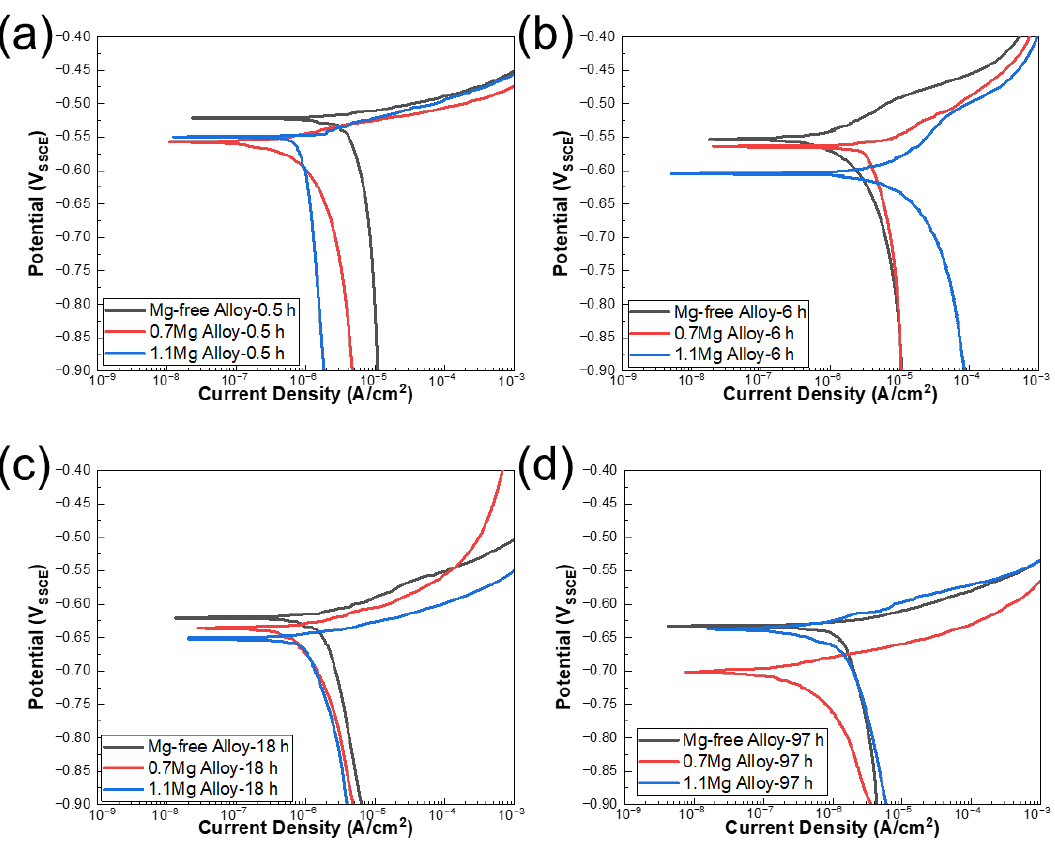
Figure 2. Potentiodynamic polarization curves of Al – Cu – Li alloys with different Mg content aged at 150 °C for ( a ) 0.5 h, ( b ) 6 h, ( c ) 18 h, ( d ) 97 h in 3.5% NaCl solution at near neutral pH. Table 2. E corr and I corr values of Al – Cu – Li – x Mg alloys extracted from potentiodynamic polarization studies in Figure 2. Time (h)